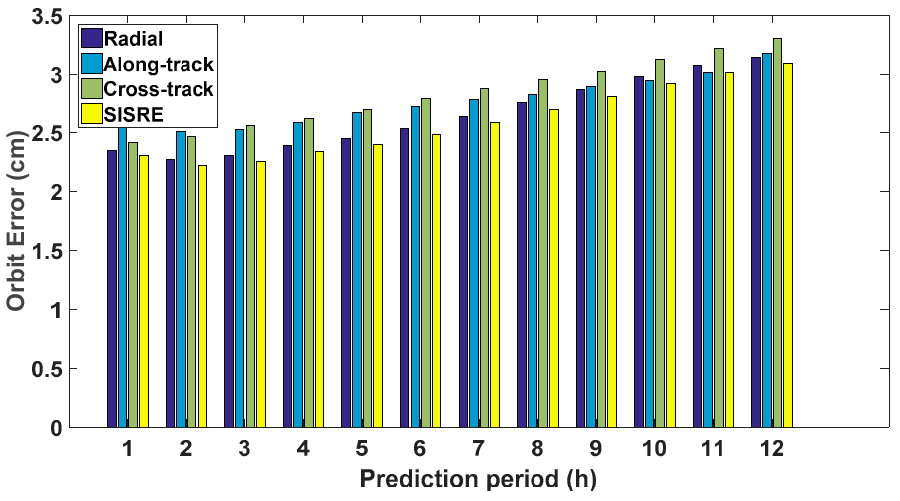
Figure 6. Average RMSE of the predicted GPS satellite orbit over 12 h.